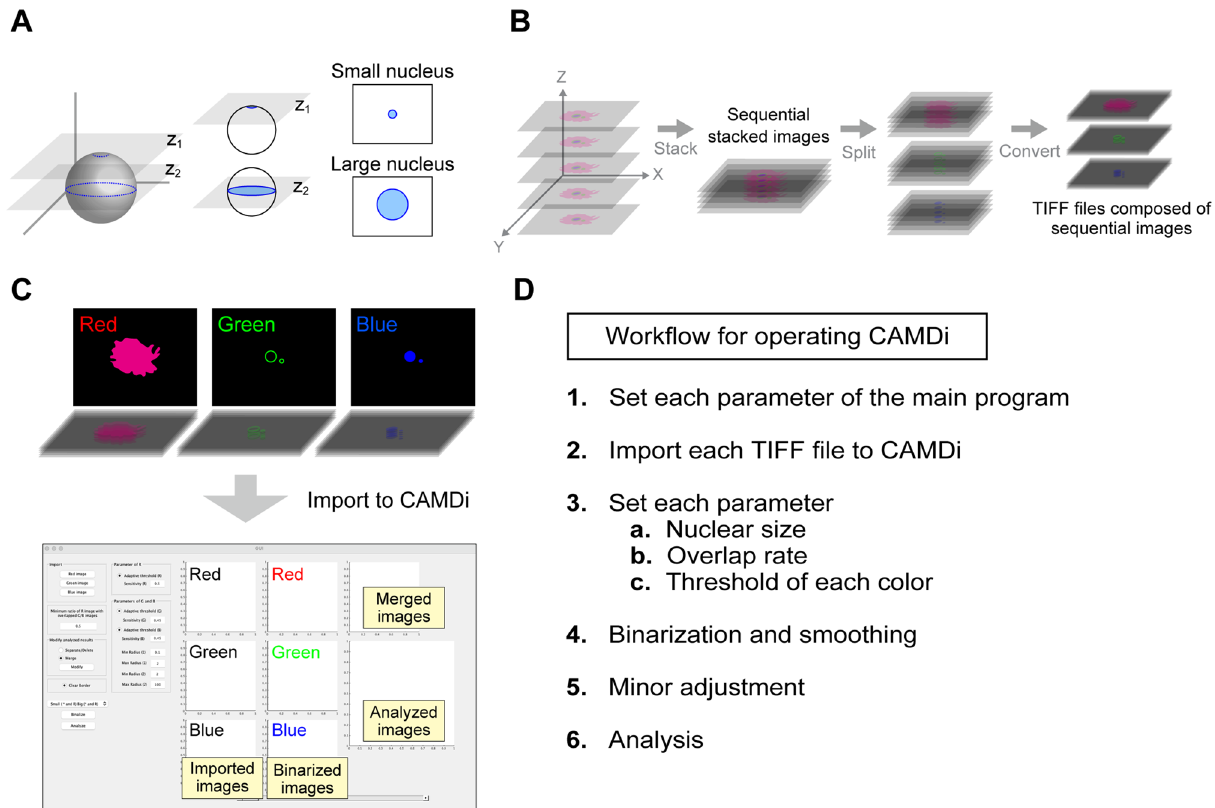
Figure 2. Developing the micronuclei analysis tool using the MATLAB-based program. ( A ) Schematic illustration of analyzing large and small nuclei. Nuclear size is altered if the images are taken from the different sections (Z 1 and Z 2 ). Z 1 : an upper section, Z 2 : a middle section. ( B ) Images need to be adjusted to a suitable format before importing into the CAMDi. Images should be a single or sequential TIFF file. Images are divided into three different colors (blue, green, and red). ( C ) Image processing step for importing data into CAMDi and representative window. Illustrations indicate cell body (red), nuclear envelope (green), and chromatin (blue). ( D ) Image processing workflow for quantification of micronuclei. Adobe Creative Could CC (Illustrator 25.0.1) (https:// www. adobe. com/) was used for all illustration preparation in Fig.